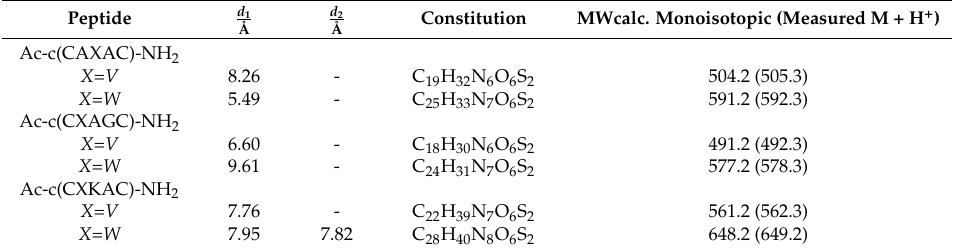
Figure 1. Scheme of calculated key distances: the distance ( d 1 ) between Trp/Val and the disulfide bridge ( A ); cation– π distance between the centroids of the benzene rings of the indole moieties of Trp and the cationic side chains of Lys ( d 2 ) and Arg( d 3 ) (the ammonium nitrogen in Lys side chain or the guanidinium carbon in Arg side chain) ( B ). Table 1. Distances ( d 1 , d 2 as shown in Figure 1) and analytical data of the selected synthetic peptide